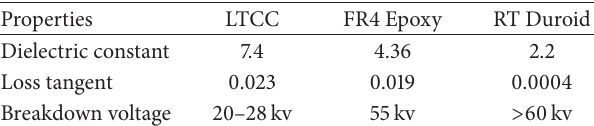
Table 2: Data sheet of different